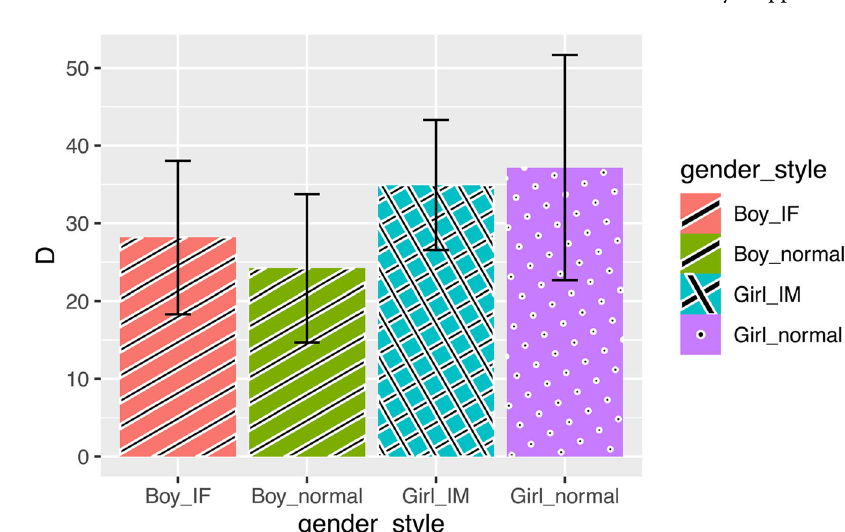
Fig. 2 The mean LR of Children ’ s compliments. The fi gure provides a cross-gender comparison of the LR in terms of D as pro fi led in children ’ s normal speech and the designed imitating context. Here boys_normal and girls_normal stand for boys ’ and girls ’ normal speech styles; boys_IF and girls_IM stand for boys ’ imitated feminine and girls ’ imitated masculine speech